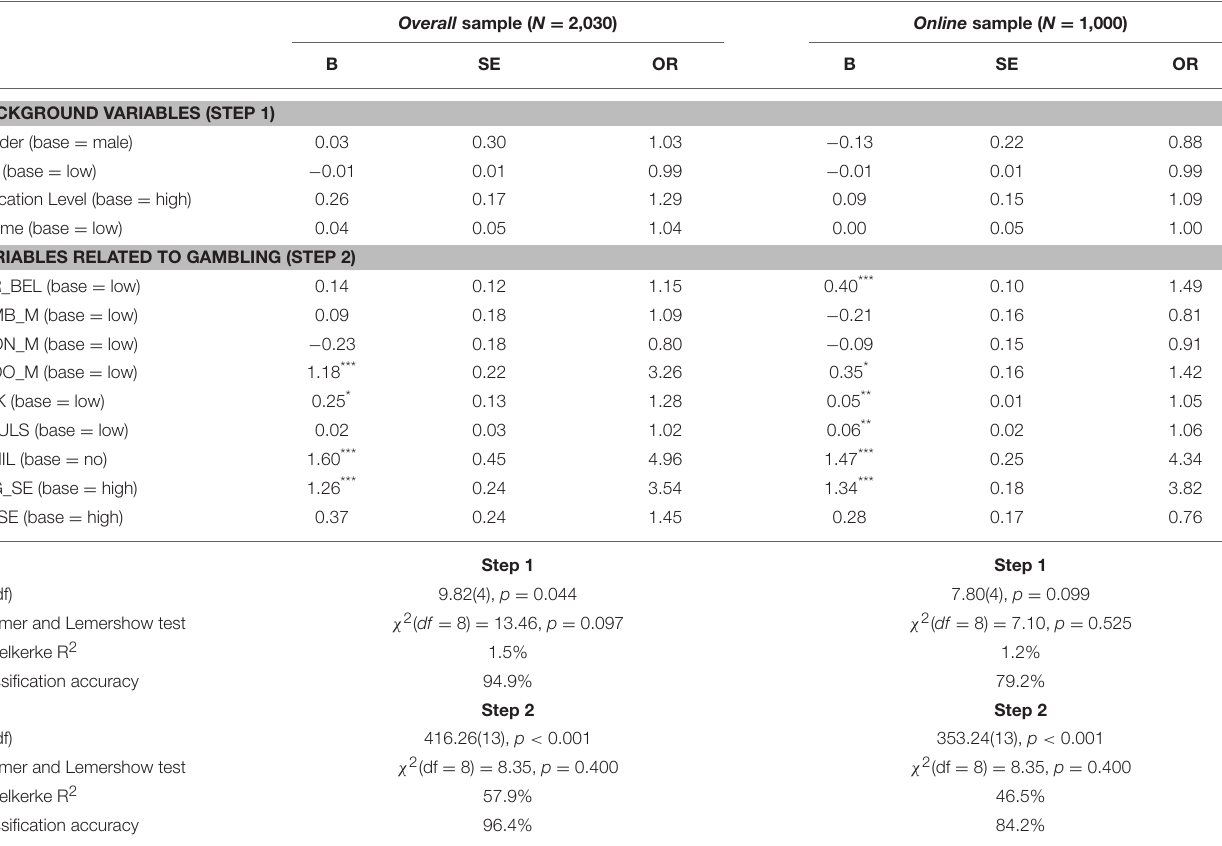
TABLE 7 | Hierarchical logistic regression results for the land-based and online